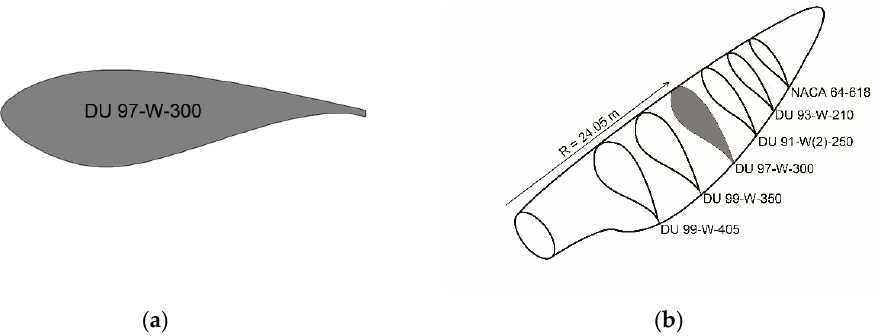
Figure 2. ( a ) DU 97W300 airfoil; ( b ) sketch of blade airfoil distribution on NREL 5 MW